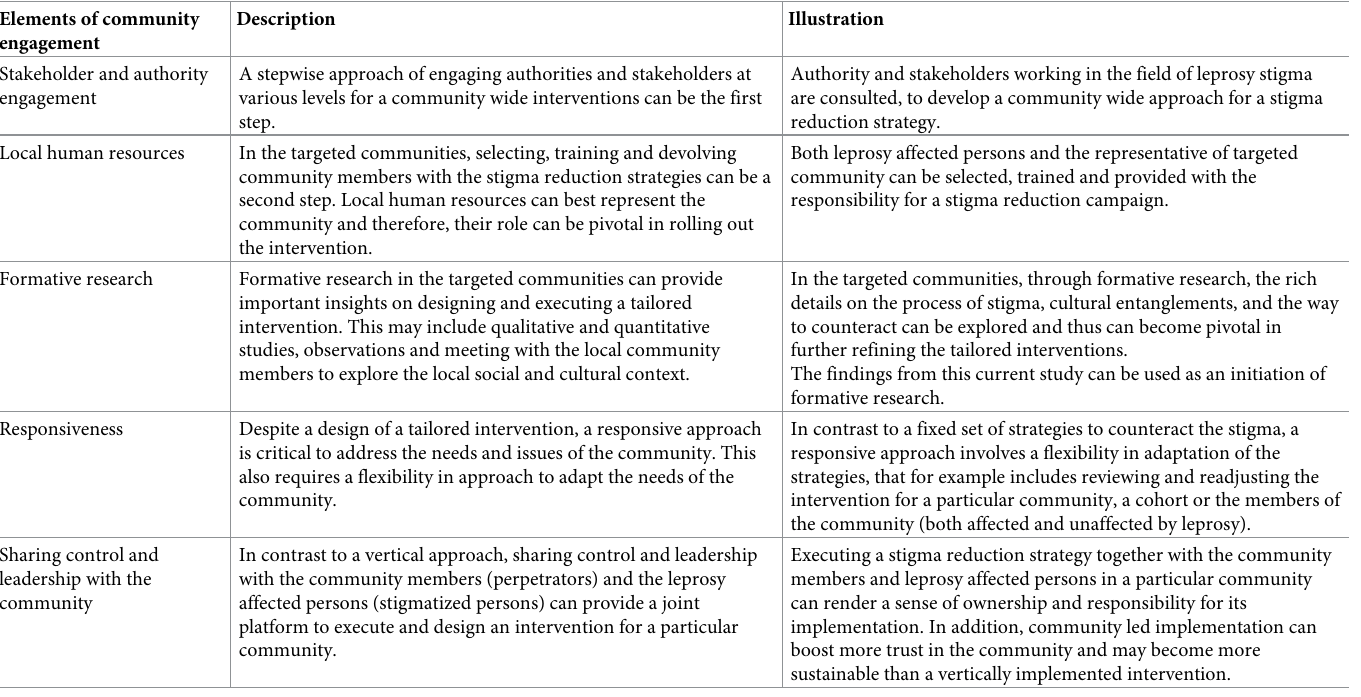
Table 2. Elements of community engagement [40] and the possible methods of its use in stigma reduction